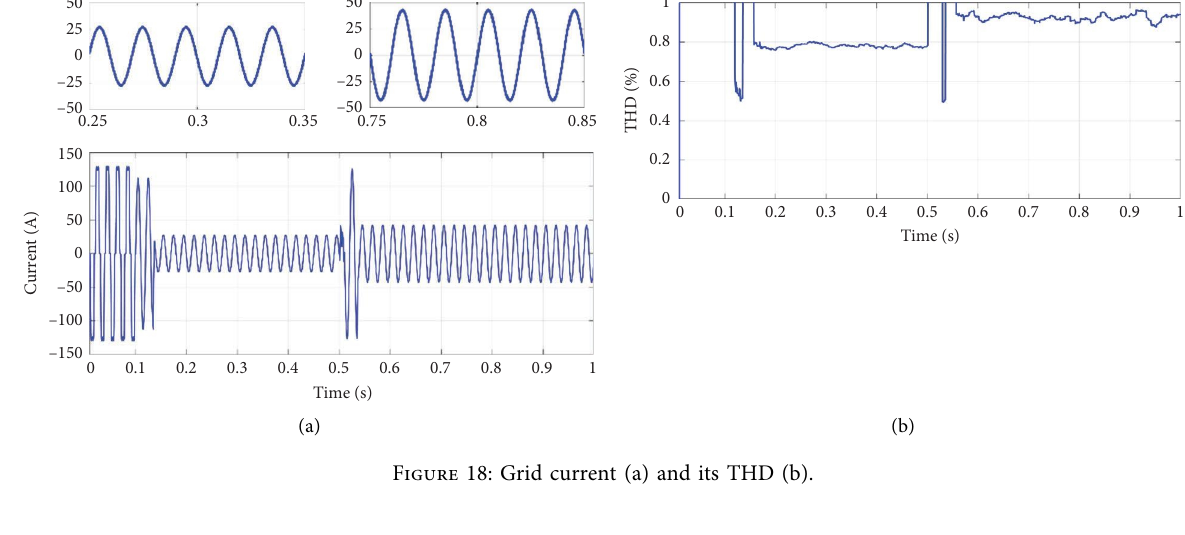
Figure 18: Grid current (a) and its THD (b).